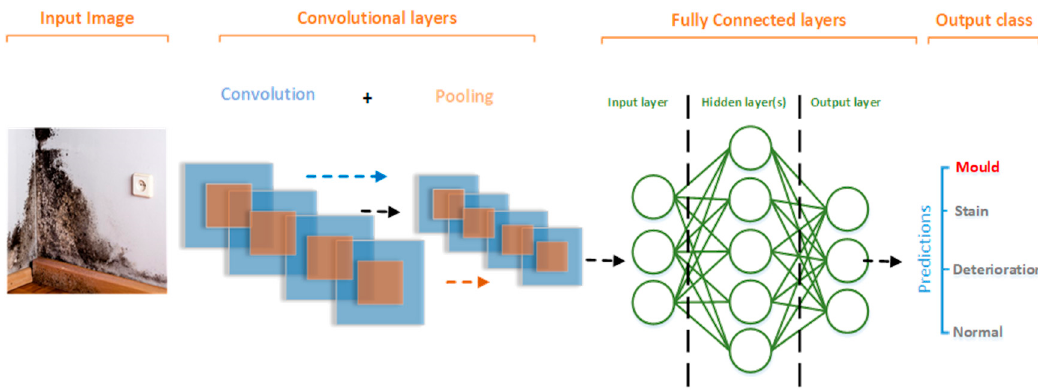
Figure 1. Basic ConvNet Architecture.